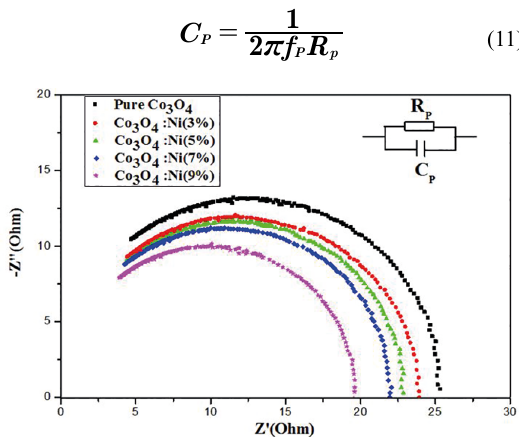
Figure 8. Nyquist plots of pure and Ni-doped Co different doping levels The variation of the resistance and capacitance as a function of Ni doping level are listed in Table 4 and shown in Fig.9. It is clear that the resistance of cobalt oxide decreases and the capacity increases with the increase of doping level. This shift is also due to the introduction of nickel ions in Co O lattice which induces a variation in the particle size 3 4 and consequently introduce more grain boundaries within the samples. Two conduction mechanisms are simultaneously present, conduction across the grain and conduction through the grain boundaries. The effect of grain boundaries in samples becomes more dominant with respect to the contribution of the grains in the conduction mechanism. Table 4. Values of fc , Rp and Cp of pure and Ni-doped Co Samples